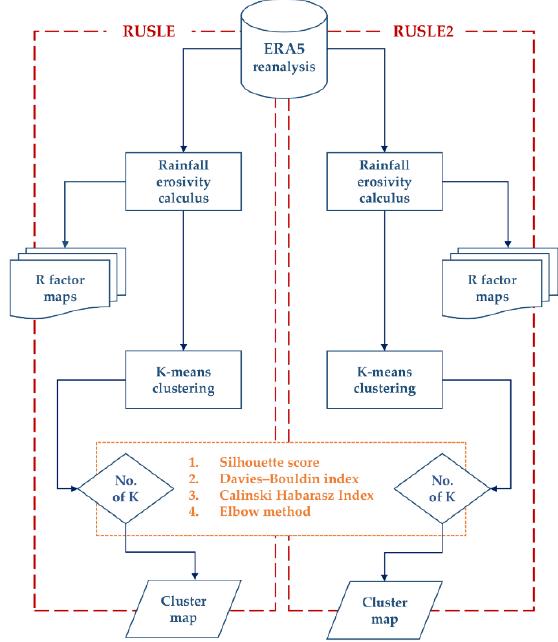
Figure 2. Research workflow.